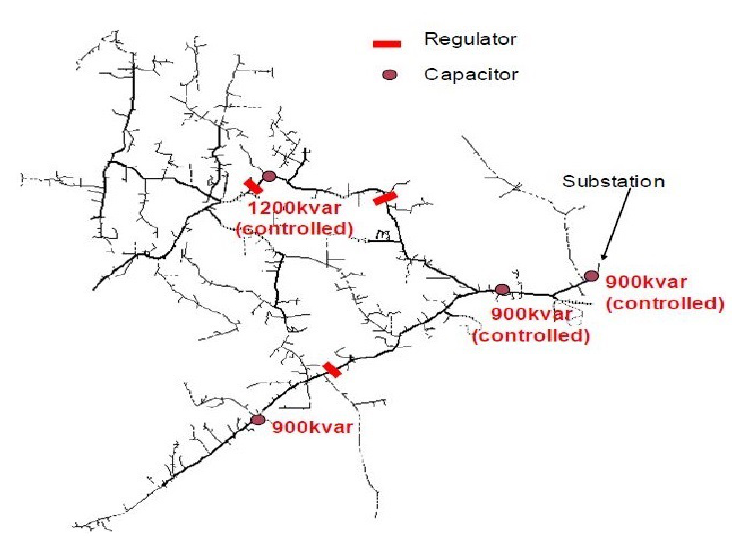
Figure 2. One line diagram of the IEEE-8500 node test Feeder [30].